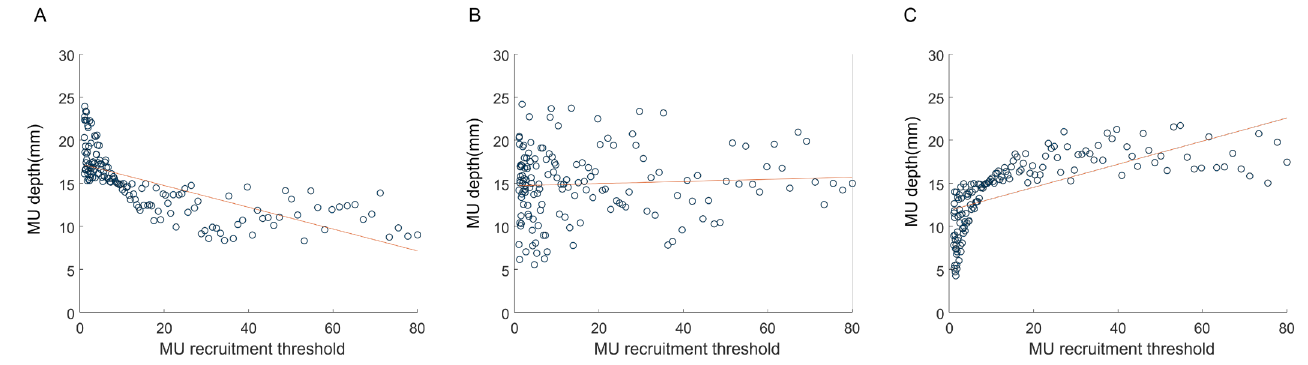
Figure 2. Three different motor unit distributions with respect to muscle depth. ( A ) motor unit depth is negatively related with motor unit size. ( B ) motor unit depth is randomly assigned. ( C ) motor unit depth is positively related to motor unit size.